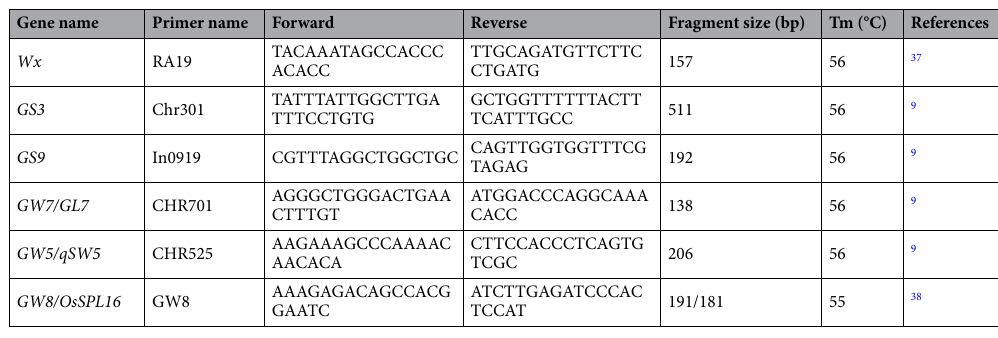
Table 1. Primers used in this work.